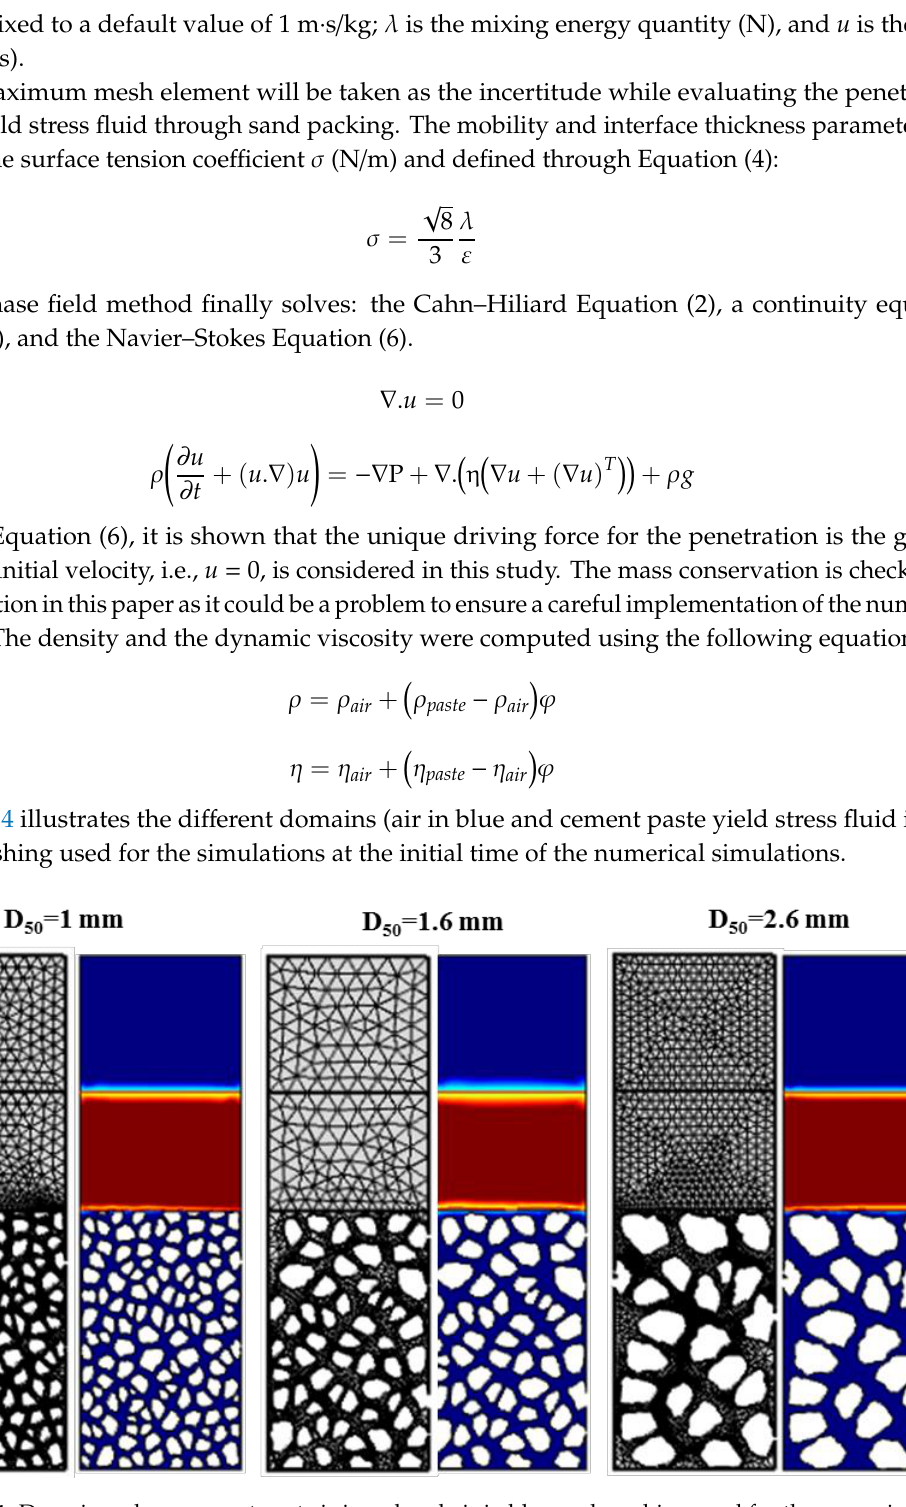
Figure 4. Domains where cement paste is in red and air in blue and meshing used for the numerical simulations using CFD module from Comsol ® software.